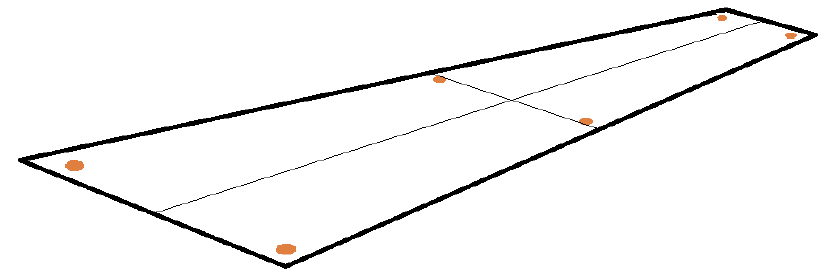
Figure 5. An example of the distribution of six GCPs within one ALS data strip divided into two segments.